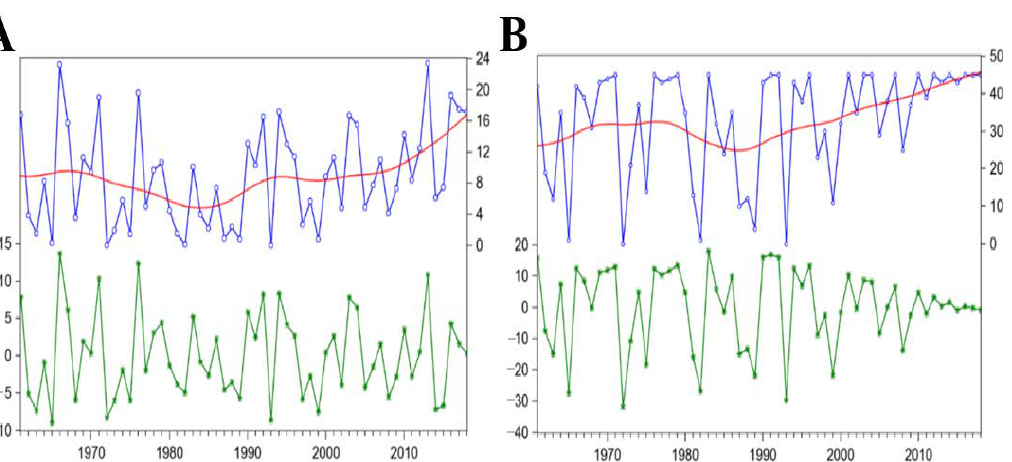
Figure 2. Interannual variation of high-temperature damage during heading and flowering of middle rice in Jianghuai from 1961 to 2018. The abscissa represents the year. ( A ) Average day per year. The green line indicates the fluctuation term. The red line indicates the trend term. The blue line indicates the average days per year. ( B ) Annual average number of sites. The green line indicates the fluctuation term. The red line indicates the trend term. The blue line indicates the annual average number of sites.